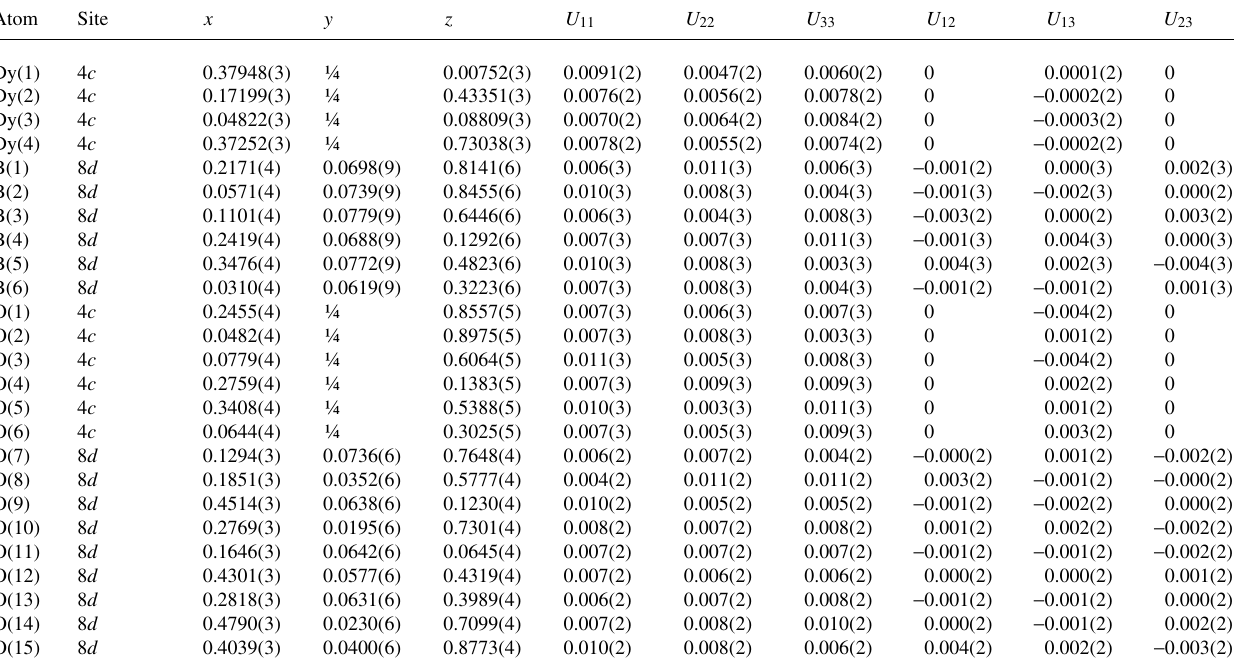
Table 2. Atomic coordinates and displacement parameters (in Å 2 )